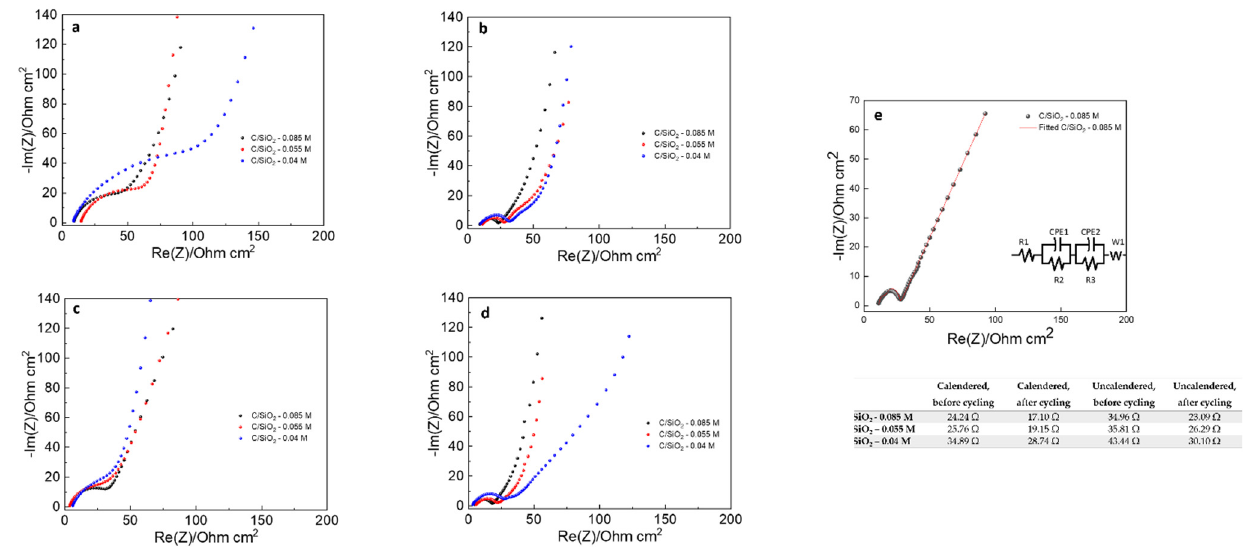
Figure 13. Electrochemical impedance spectroscopy of ( a ) C/SiO 2 -0.04 M, C/SiO 2 -0.055 M, and C/SiO 2 -0.085 M, uncalen- dered electrodes before cycling; ( b ) C/SiO 2 -0.04 M, C/SiO 2 -0.055 M, and C/SiO 2 -0.085 M, uncalendered electrodes after cycling; ( c ) C/SiO 2 -0.04 M, C/SiO 2 -0.055 M, and C/SiO 2 -0.085 M, calendered electrodes before cycling; ( d ) C/SiO 2 -0.04 M, C/SiO 2 -0.055 M, and C/SiO 2 -0.085 M, calendered electrodes after cycling; ( e ) The equivalent circuit of the C/SiO 2 -0.085 M uncalendered electrode after 200 cycles.